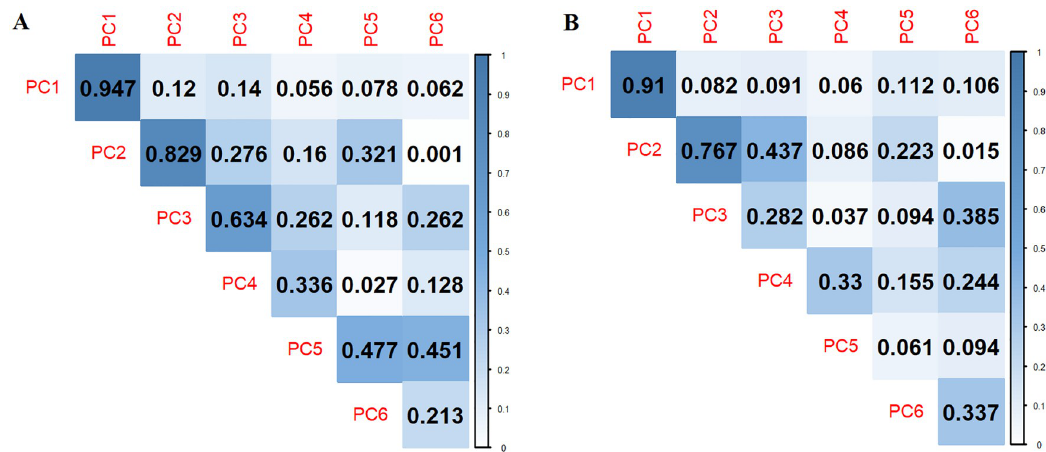
Fig 4. Correlations in the first six Principal Components (PCs) between estimated and GS landmarks. (A) MALPCA vs. GS. (B) ALPACA (the synthetic template) vs. GS. PC scores are derived from separate GPAs of estimated and manual landmarks. Each grid represents the correlation coefficient between a PC from an automated landmarking analysis and a PC from the GS, depending on its row and column names.